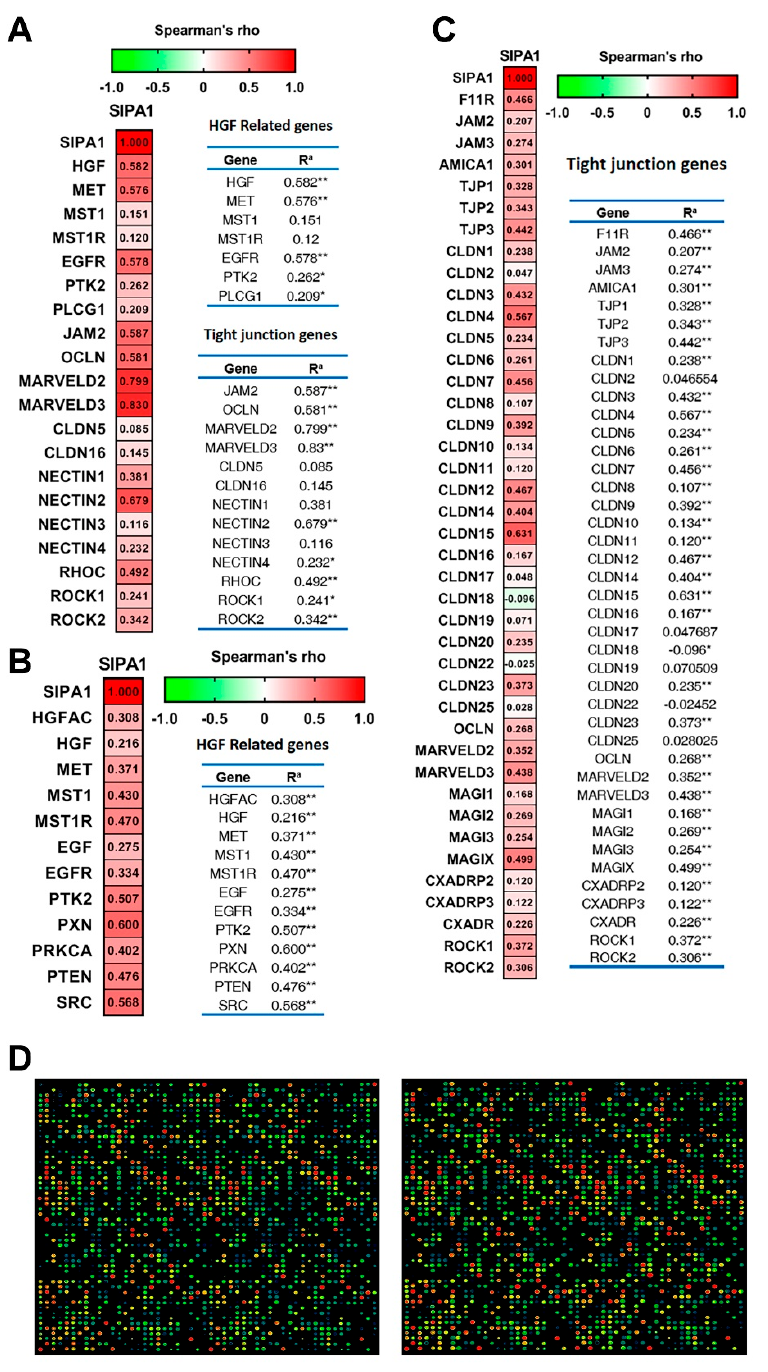
Figure 5. Correlation coefficient of SIPA1 with key HGF/MET components and tight junction markers. ( A–C ) show the Spearman’s rank correlation coefficient between SIPA1, HGF related genes and tight junction component genes analyzed from the Peking lung cancer cohort ( A ), and Spearman’s rank correlation coefficient between SIPA1 and HGF related genes ( B ), tight junction component genes ( C ) analyzed from TCGA-LUAD database. ( D ) Overall images of a direct fluorescent-dye labelled KAM-1325 antibody microarray slide detecting the protein sample from the A549 pEF control cells (left) and A549 SIPA1 knockdown cells (right). * and ** denotes statistical significance, i.e., p values below 0.05.